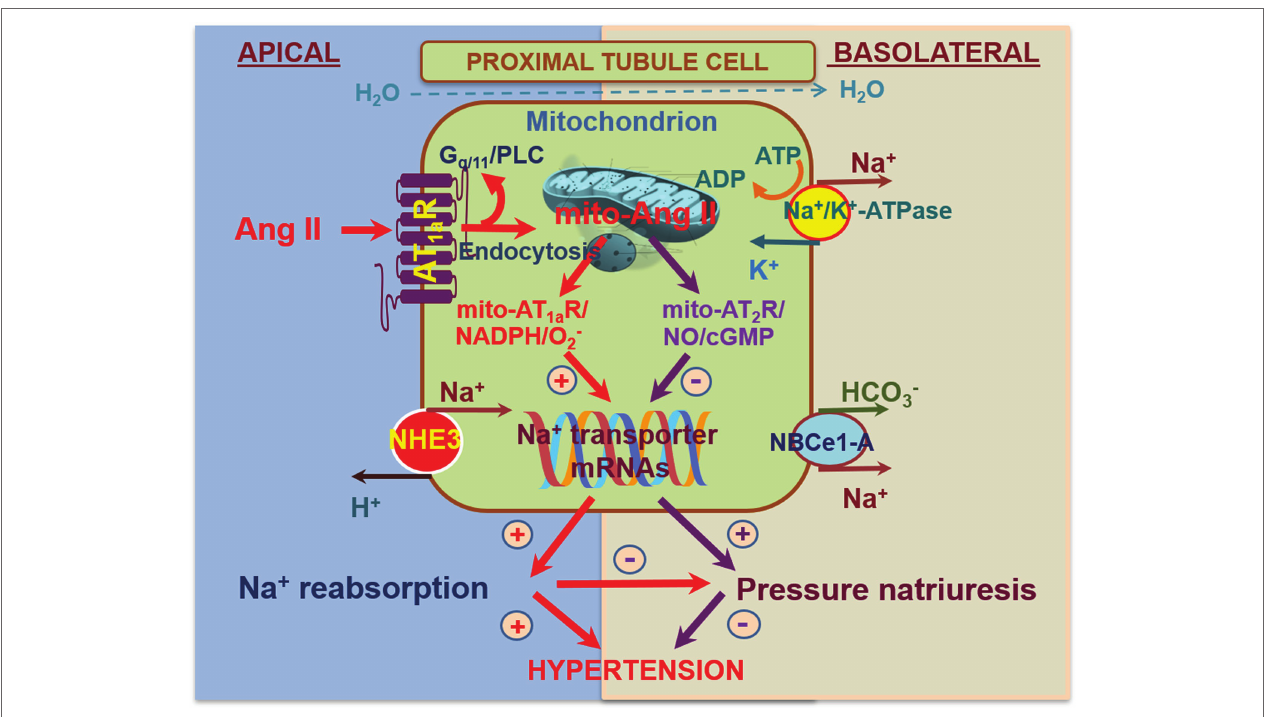
FIGURE 4 | Schematic diagram showing the hypothesis for novel biological and physiological roles of intracellular Ang II system in the mitochondria of the proximal tubules in the regulation of proximal tubule Na + reabsorption and blood pressure homeostasis. In addition to local onsite generation, extracellular (endocrine and paracrine) Ang II is taken up by the proximal tubule cells via the AT 1 (AT 1a ) receptor-mediated mechanism. Some internalized Ang II/AT 1 receptor complexes bypass the lysosomal degradation pathway and be transported to other intracellular organelles, including the mitochondria and the nucleus, where Ang II activates AT 1 and/ or AT 2 receptors in the mitochondria to alter mitochondrial oxidative and glycolysis stress responses. This may in turn alter the expression or activity of NHE3 on the apical membranes or Na + /K + -ATPase on the basolateral membranes in the proximal tubules. Thus, activation of the mito-Ang II/AT 1 / 2 o - signaling will stimulate proximal tubule Na + reabsorption and elevate blood pressure. Conversely, activation of the mito-Ang II/AT 2 /NO/cGMP signaling by overexpressing AT 2 receptors selectively in the mitochondria will likely inhibit proximal tubule Na + reabsorption, induce natriuretic response, and lower the blood pressure. Reproduced with permission (Li et al.,